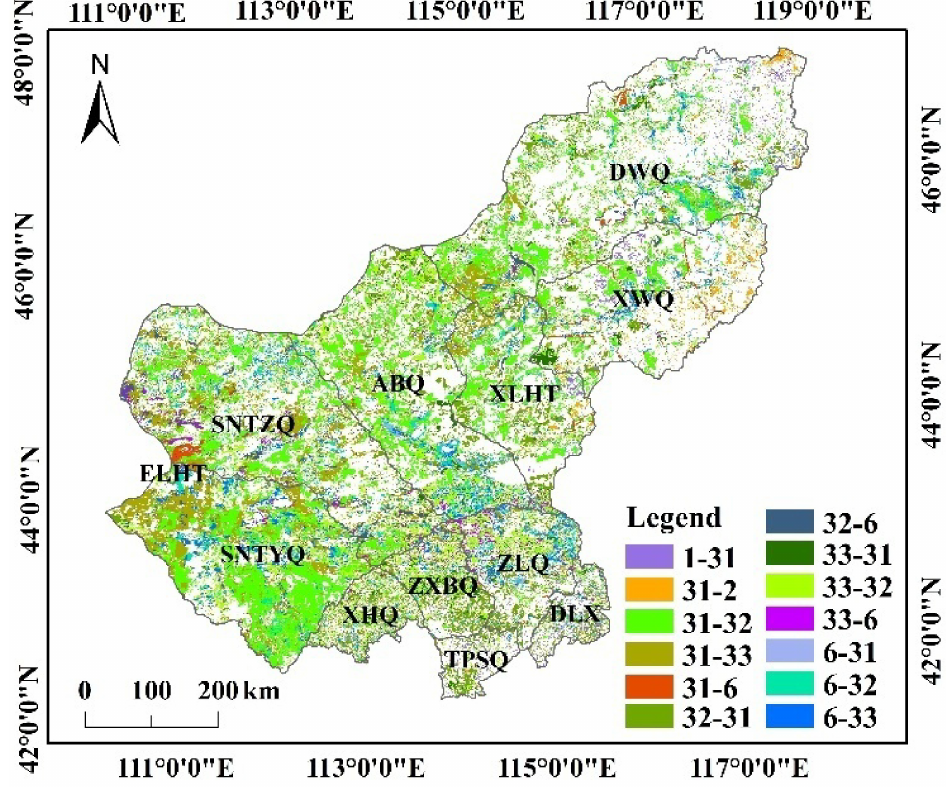
Figure 8. Spatial pattern of each type of change in land-use between 1980 and